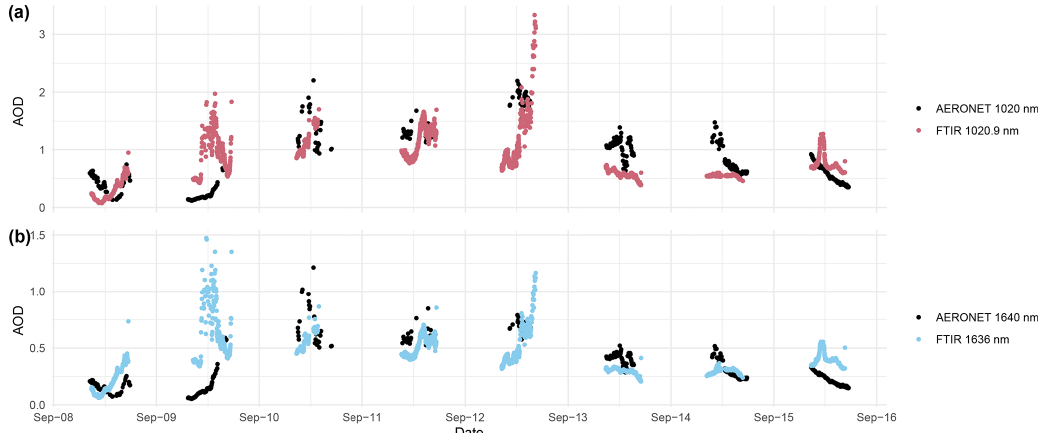
Figure B3. Time series of AOD from FTIR for the (a) 1020.9nm (red) and (b) 1636nm (blue) windows and AERONET (black) located in Fresno, CA, ∼ 90km north of the measurement site.